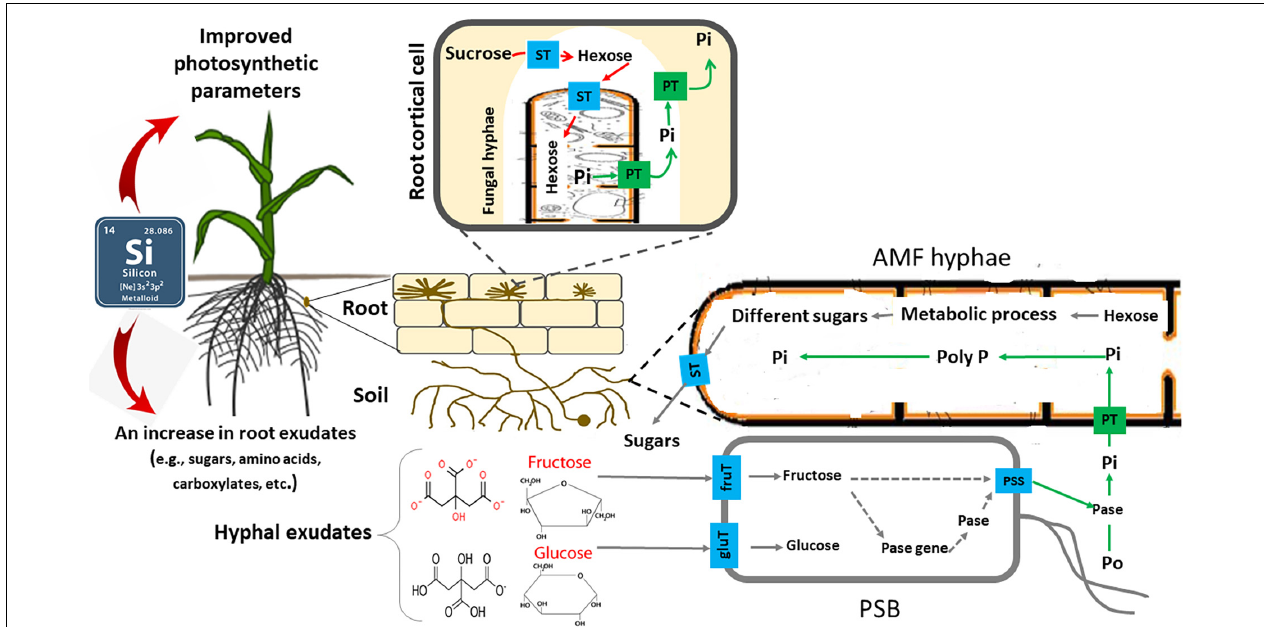
FIGURE 3 | Schematic representation of role of silicon (Si), arbuscular mycorrhizal fungi (AMF), and phosphate-solubilizing bacteria (PSB) in mineralizing organic phosphorus (Po). Si increases photosynthetic products in root and rhizosphere by improving photosynthetic parameters of plant. The fructose exuded by AMF stimulates the expression of phosphatase genes in PSB as well as the rate of phosphatase release into the growth medium by regulating their protein secretory system. The phosphatase activity is subsequently increased, promoting the mineralization of Po (i.e., phytate) into Pi, stimulating simultaneously the processes involved in P uptake by the AMF. ST, sugar transporter; fruT, fructose transporter; glut, glucose transporter; PT, phosphate transporter; PSS, protein secretory system; Pase, phosphatase; Pi, inorganic P; and Po, organic P. For more details, see Zhang et al.